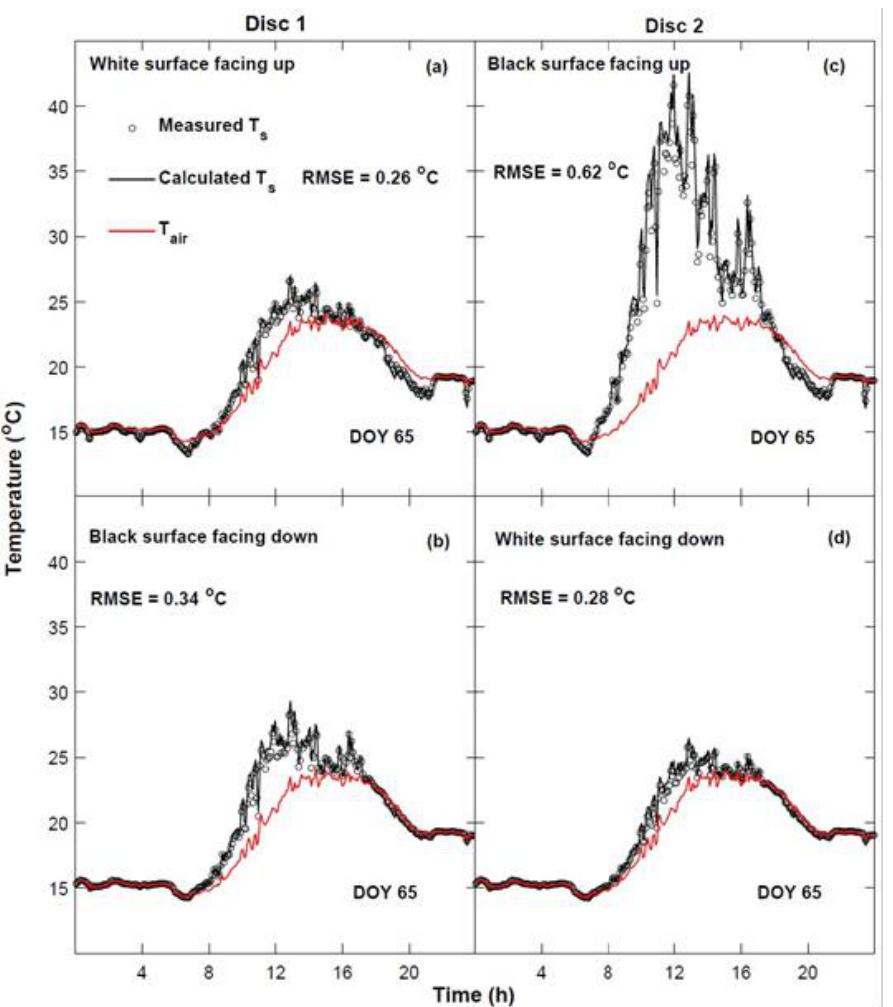
Figure 5. Calculated and measured surface temperature of the discs on day of year (DOY) 65. Disc 1 had its upper surface painted white ( a ) and its lower surface painted black ( b ), whereas Disc 2 was the opposite ( c , d ). Deviation between measured and calculated values for each surface is given by the root mean square error (RMSE).